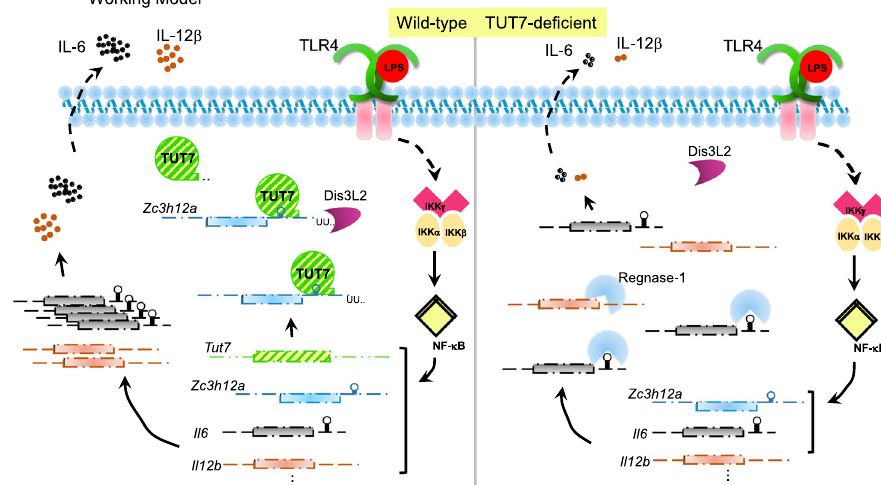
Fig. 7 Model for the regulation of TUT7-mediated Regnase-1 expression. In response to TLR4 activation, IKK complex phosphorylates I κ B α to promote NF- κ B-driven transcription. Messenger RNAs of IL-6, IL-12 β , Regnase-1, and TUT7 are upregulated. TUT7 targets and uridylates Zc3h12a on the stem-loop structure of Zc3h12a 3 ′ -UTR. Uridylated Zc3h12a transcripts are eliminated by exonuclease, probably Dis3L2, leading to upregulation of the expression of a subset of cytokines, including IL-6 and IL-12 β , at the early stage during TLR4-triggered in fl ammation. When TUT7 is depleted, elevated Regnase-1 results in a substantial decrease in IL-6 and IL-12 β expression. The dashed and solid lines indicate indirect and direct pathways,